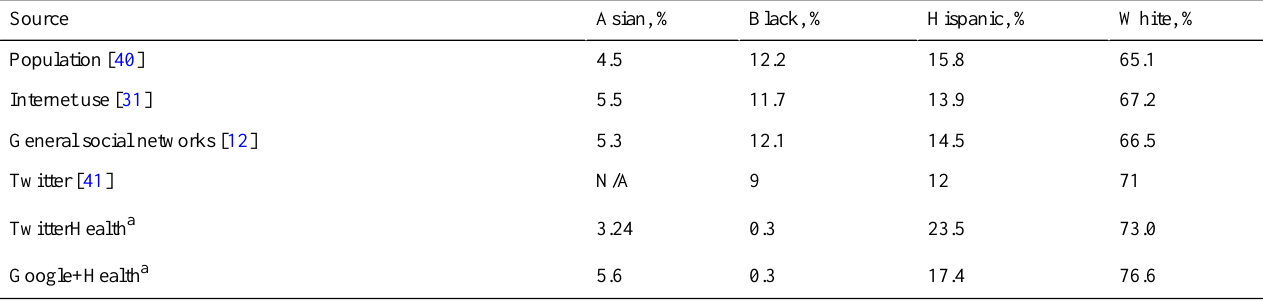
Table 5. Ethnicity distribution for TwitterHealth, Google+Health, and other relevant populations.